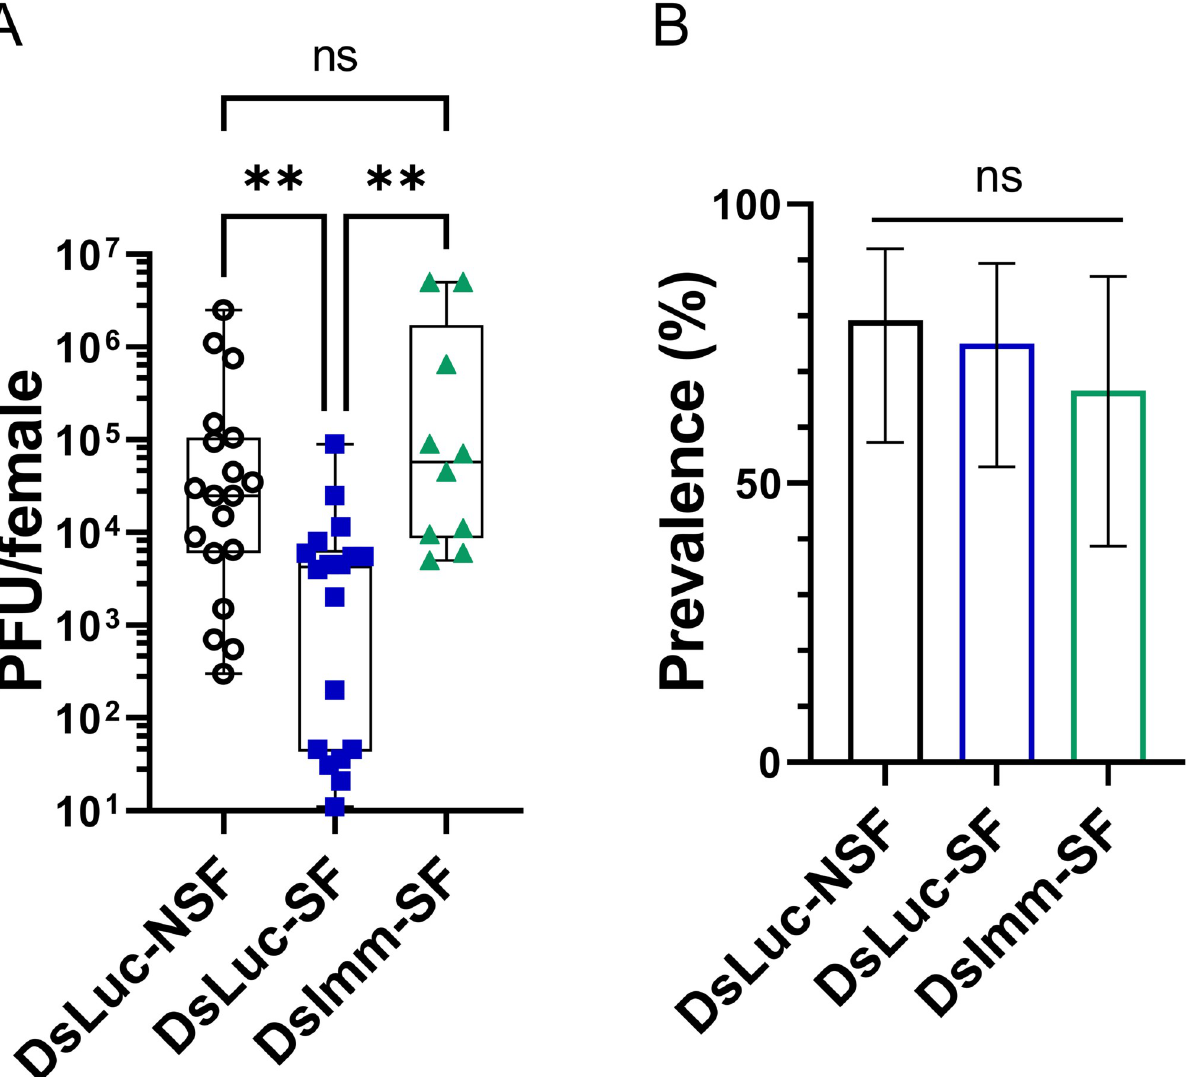
Fig 8. Sugar-mediated protection against arboviral infection is mediated by sugar-enhanced immunity. Females treated with antibiotics, were injected with dsRNA targeting either luciferase (dsLuc, control) or targeting runx4 , piwi4 , dcr2 and myd88 simultaneously (dsImm). Two days later, females were starved before being fed with 10% sucrose (dsLuc-SF and dsImm-SF) or not (dsLuc-NSF). Females received an SFV-infected blood meal at a titre of 7.8 x 10 7 PFU/mL 16 h post sugar feeding time. All females were given access to sucrose solution 30 h after the infectious blood meal. (A) Virus titration by plaque assays of whole females four days post infection. N = 15–24 females per condition. Only infected samples (with 5 PFU or more per tissue, i . e . at least one plaque in one of the two replicate wells at the first dilution) were plotted on the graphs. Box plots display the minimum, first quartile, median, third quartile, and maximum. Data were analysed using Kruskal-Wallis with Dunn’s multiple comparison test. (B) SFV infection prevalence (in percentage). Lower and upper limits of the 95% confidence interval were calculated using the Wilson score interval method with a correction for continuity. Statistical significance of the treatments effect on prevalence were assessed with a Chi-square test (compared to dsLuc-NSF group). ns, p value > 0.05; �� , p value < 0.01. Numbers of infected females and total number of females per group detailed in S8 Fig.